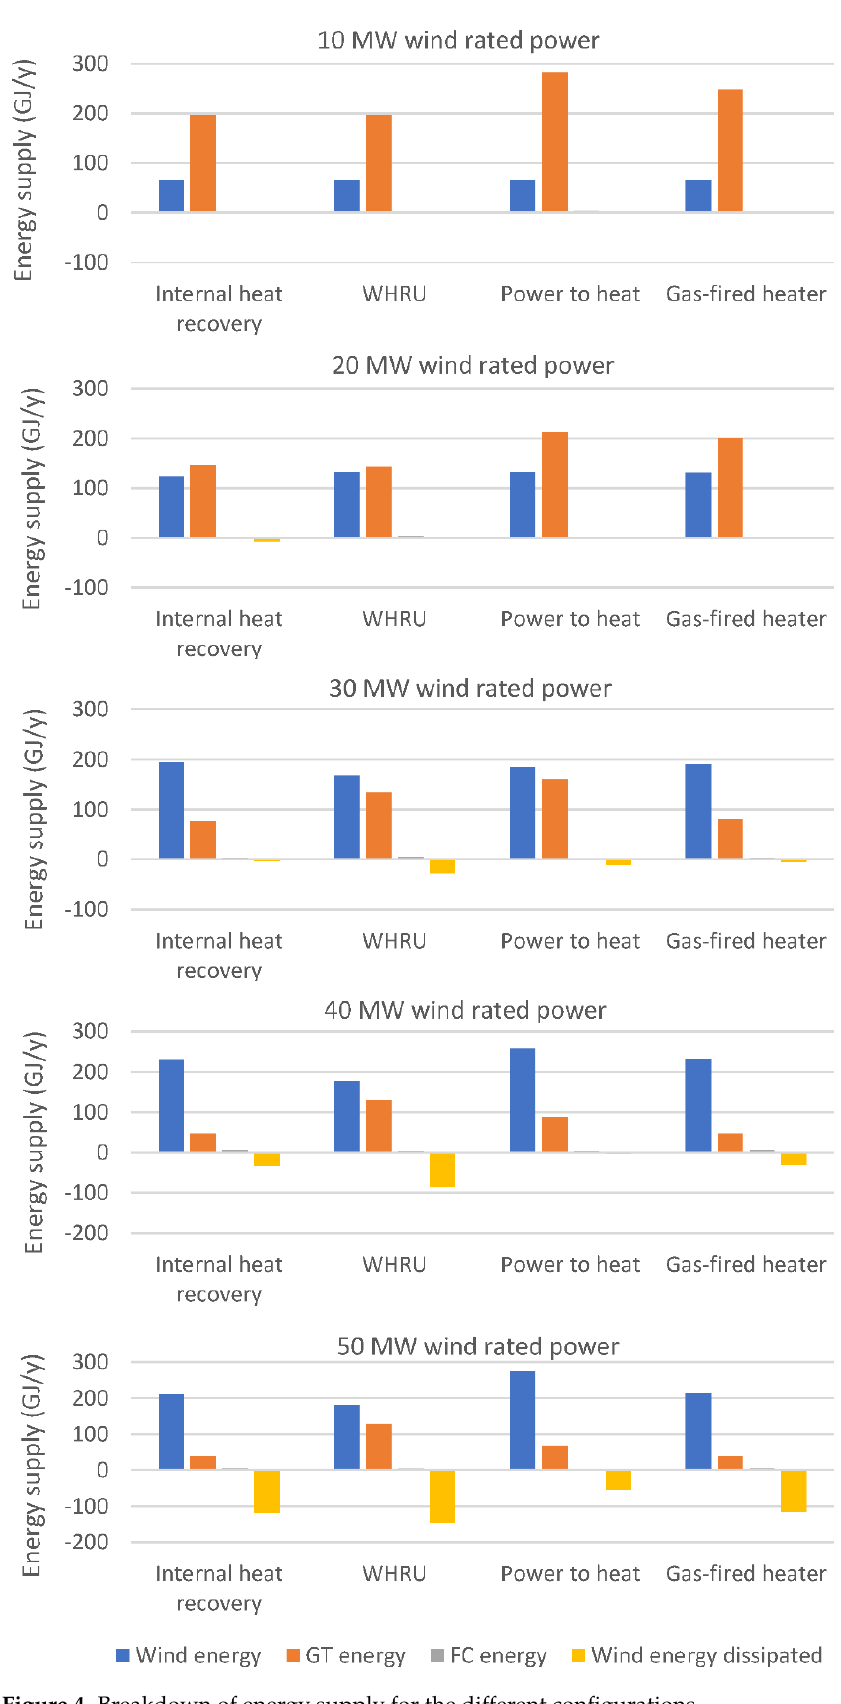
Figure 4. Breakdown of energy supply for the different configurations.